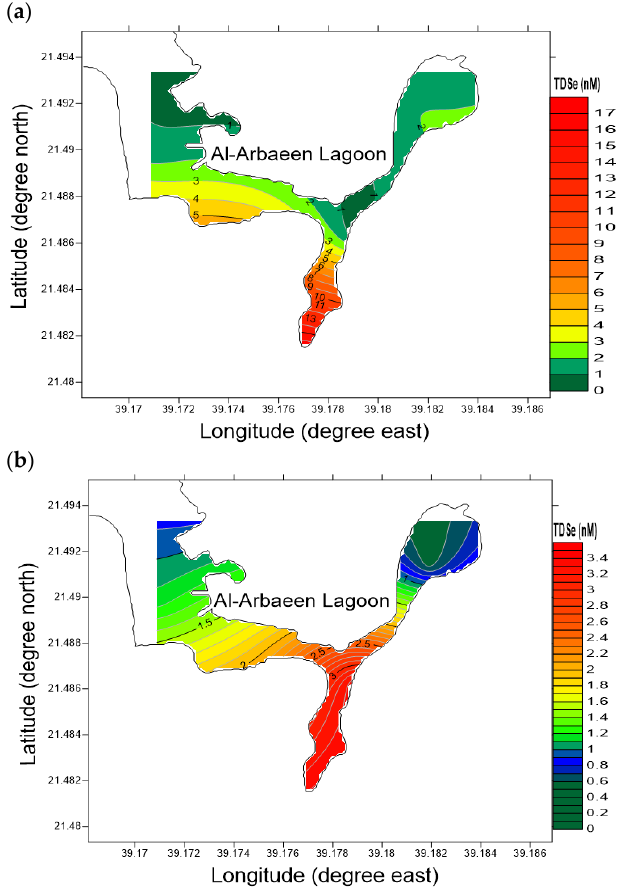
Figure 3. Total dissolved selenium horizontal distribution along Al-Arbaeen lagoon: ( a ) surface water and ( b ) bottom